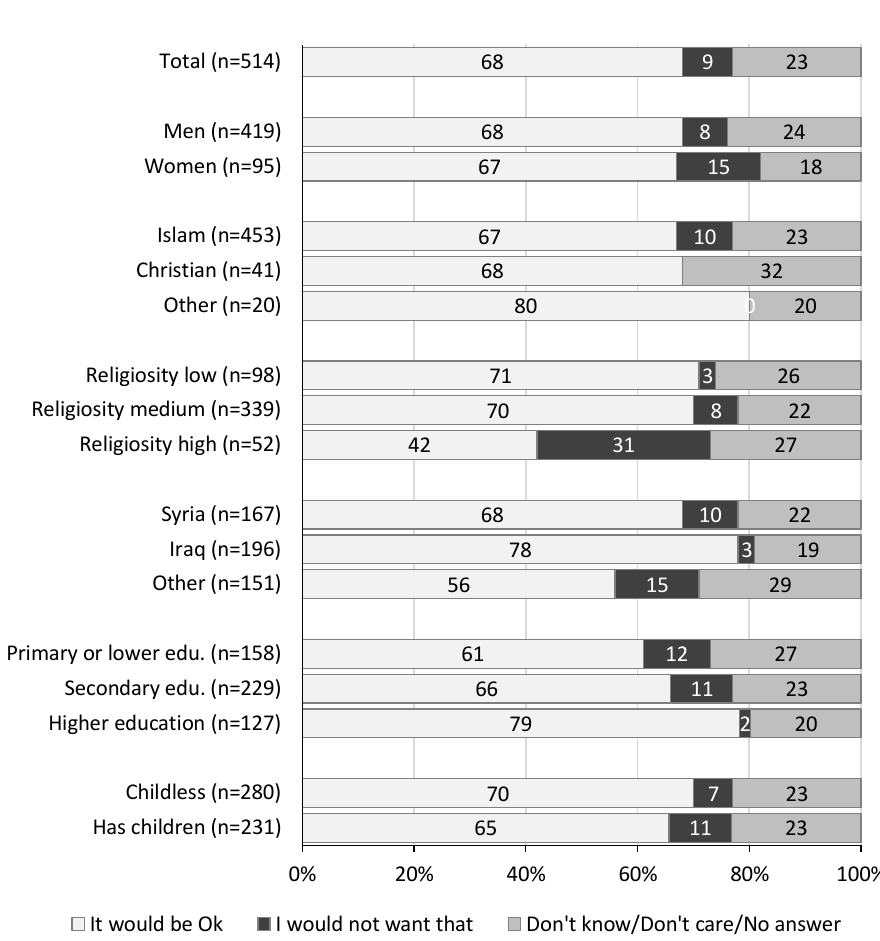
Figure 3. Tolerance towards teaching of other religions to own children in school. Source: DiPAS#1 ( n = 514 persons).